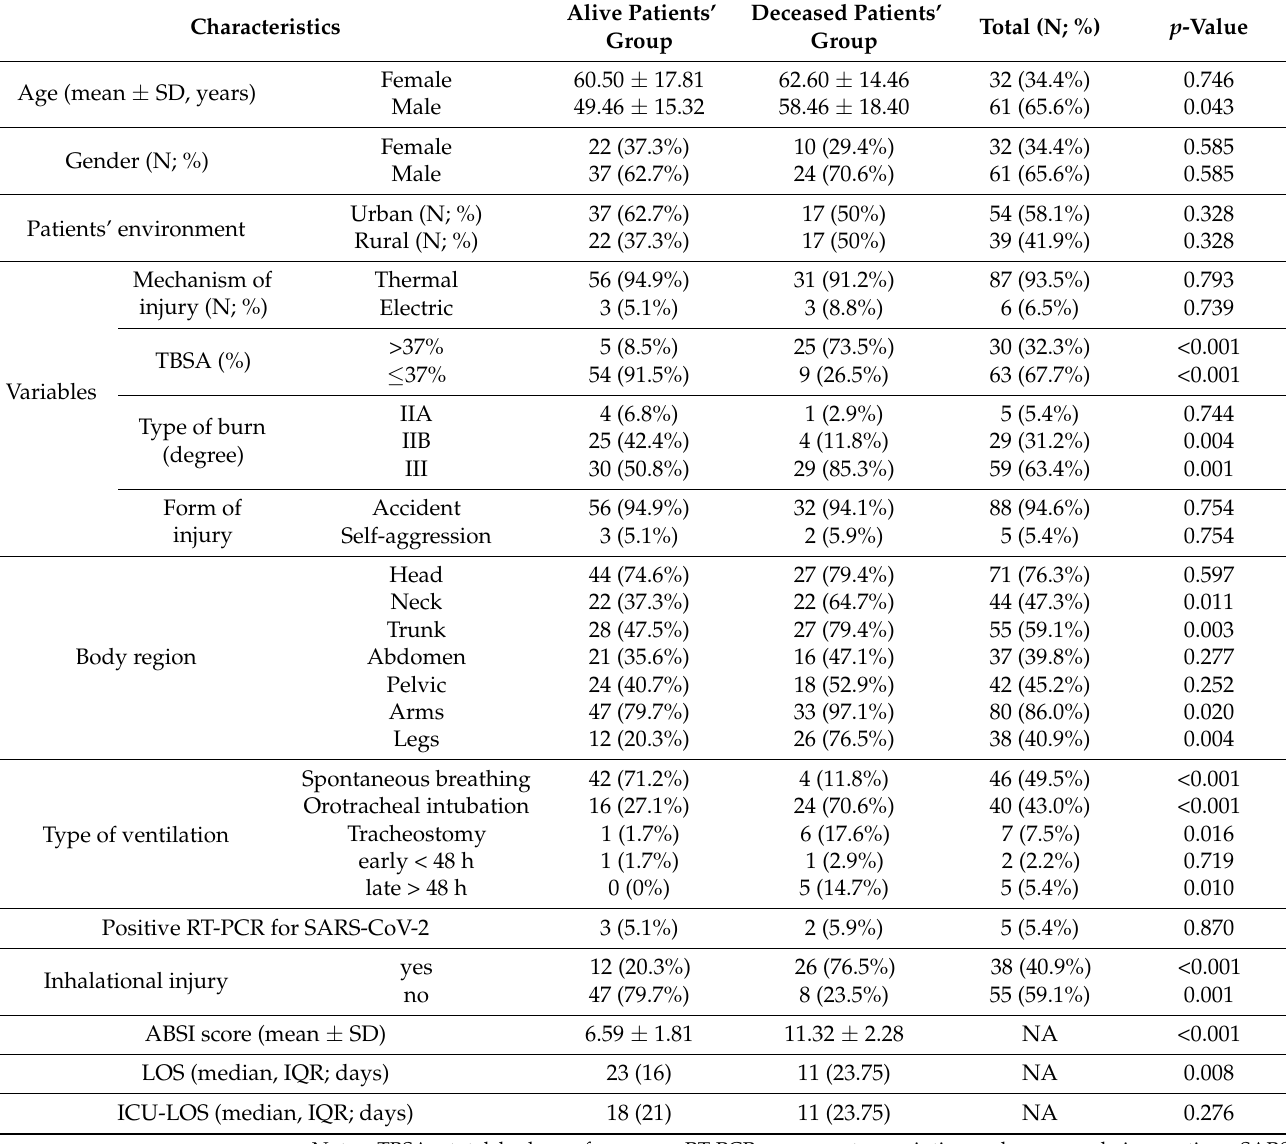
Table 1. Characteristics and distribution of the studied